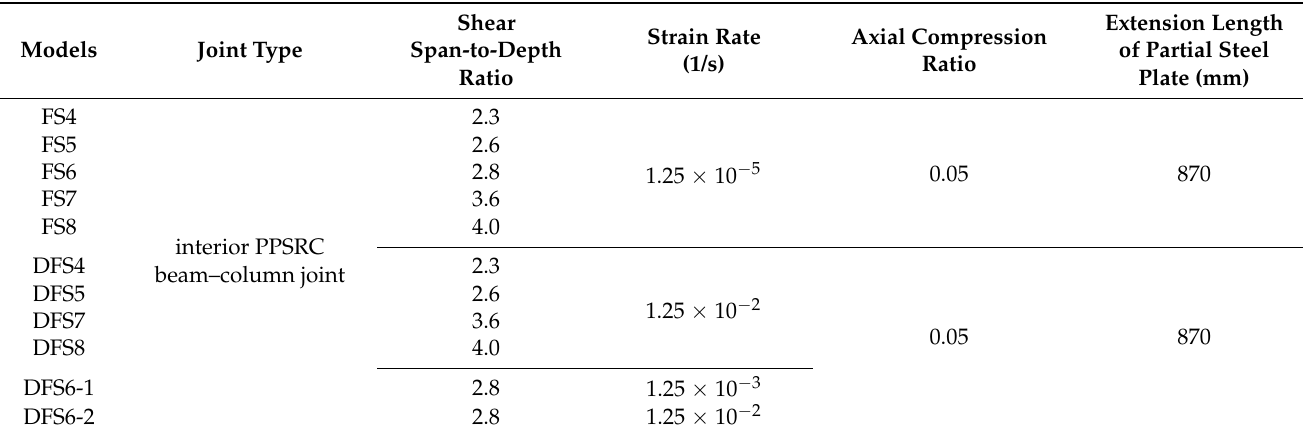
Table 4. Basic information of finite element analysis models.